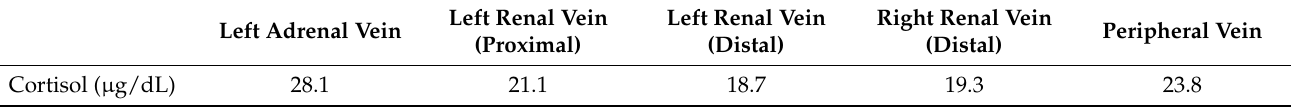
Table 2. Laboratory results of venous